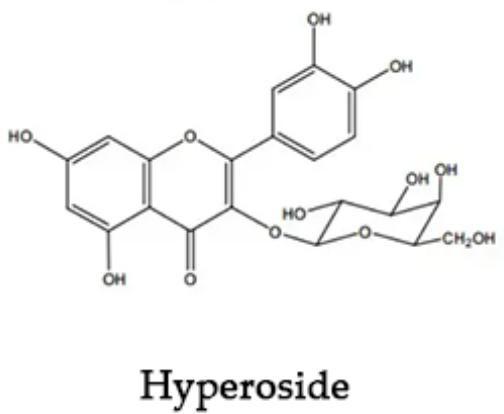
Figure 1. Chemical structure of Hyperoside .